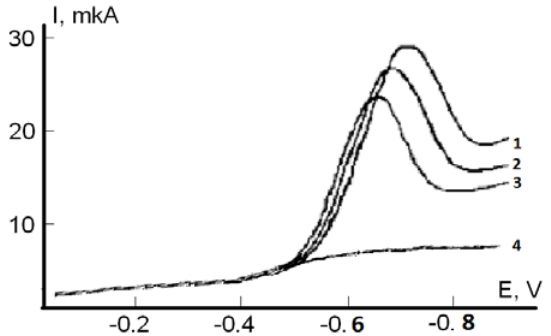
Figure 2. Voltammograms of the ER O current in phosphate buffer (0.025 M, pH 7.3) on 2 the GCE, without (1) and with 0.2 mL of serum blood at t = 5 min (2), t = 10 min (3). (4) is the residual current without oxygen in the solution.